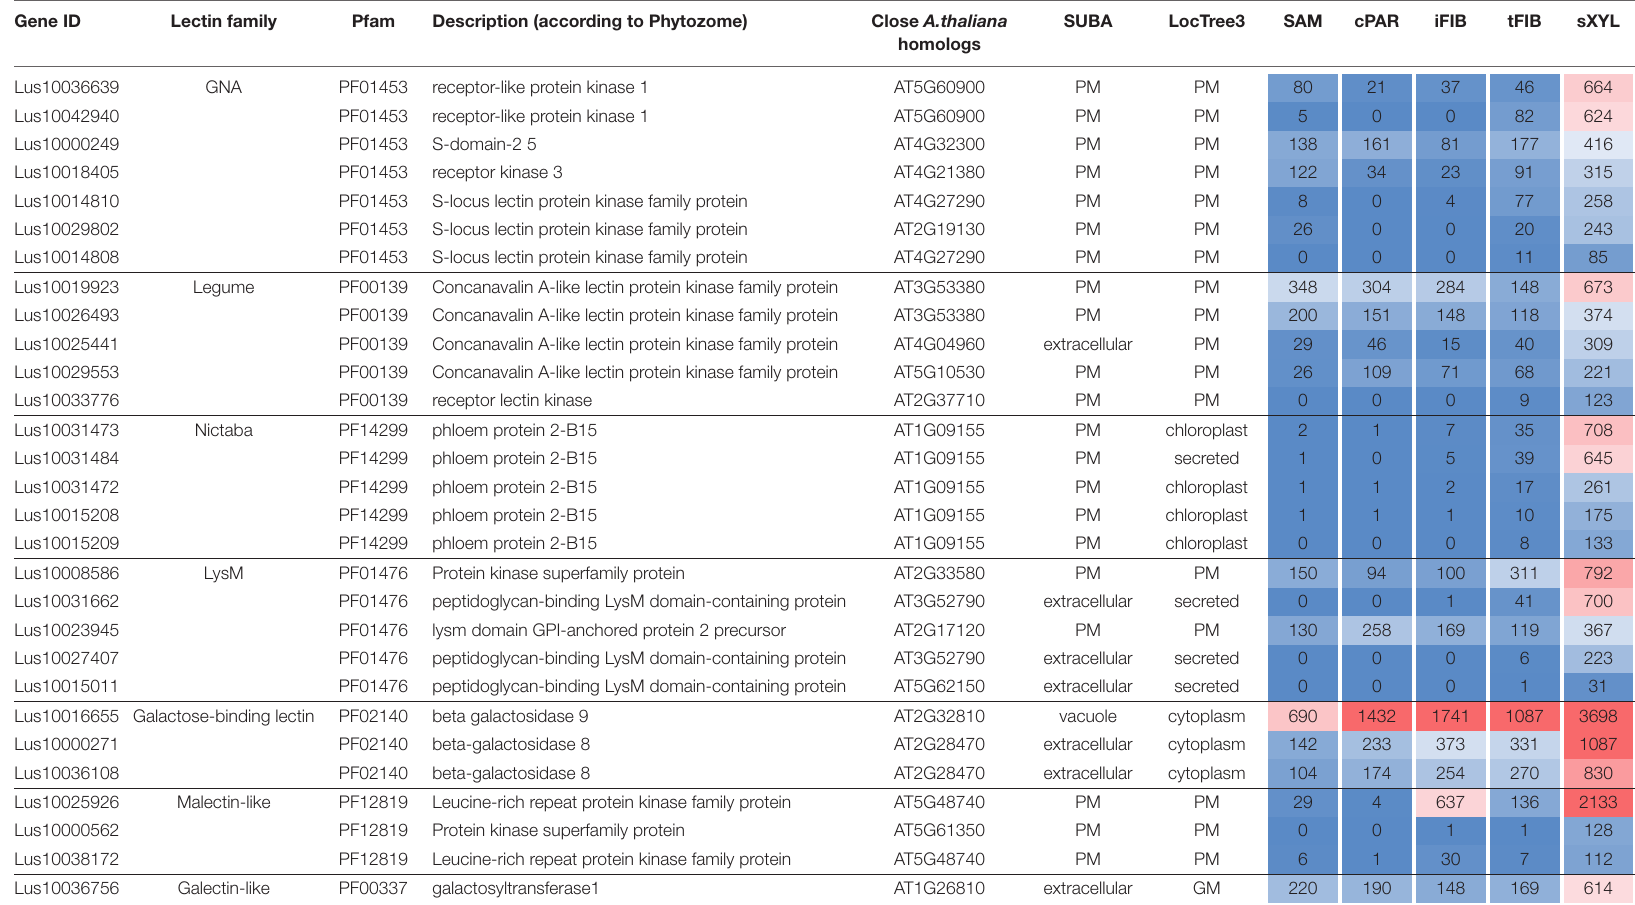
TABLE 4 | Linum usitatissimum genes encoding proteins with lectin domains upregulated in flax stem tissue samples with the secondary cell wall. Gene